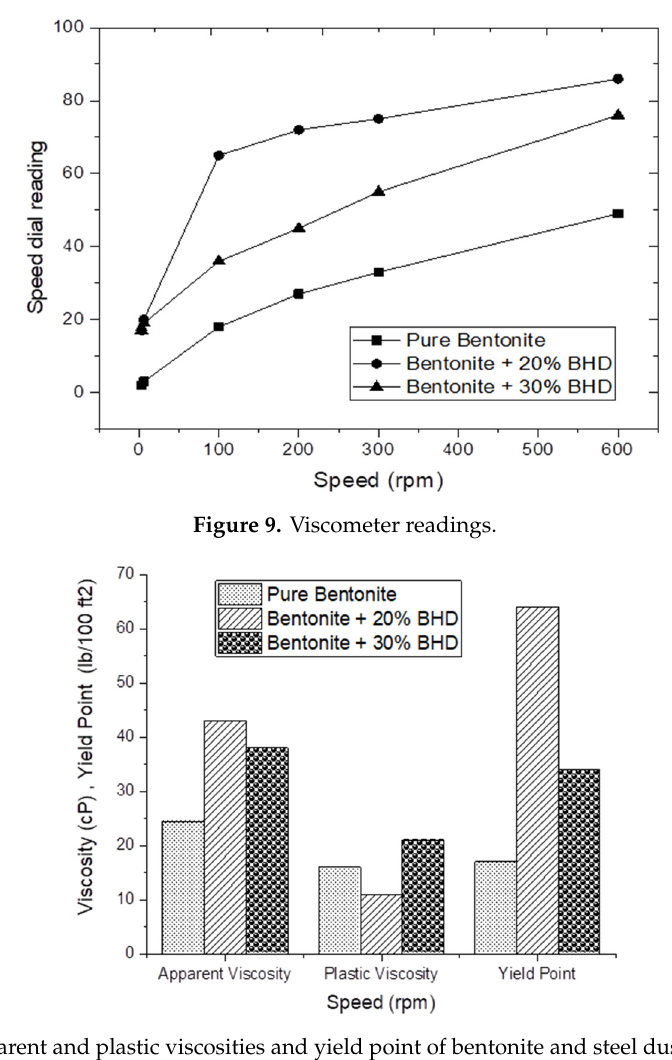
Figure 10. Apparent and plastic viscosities and yield point of bentonite and steel dust mixture